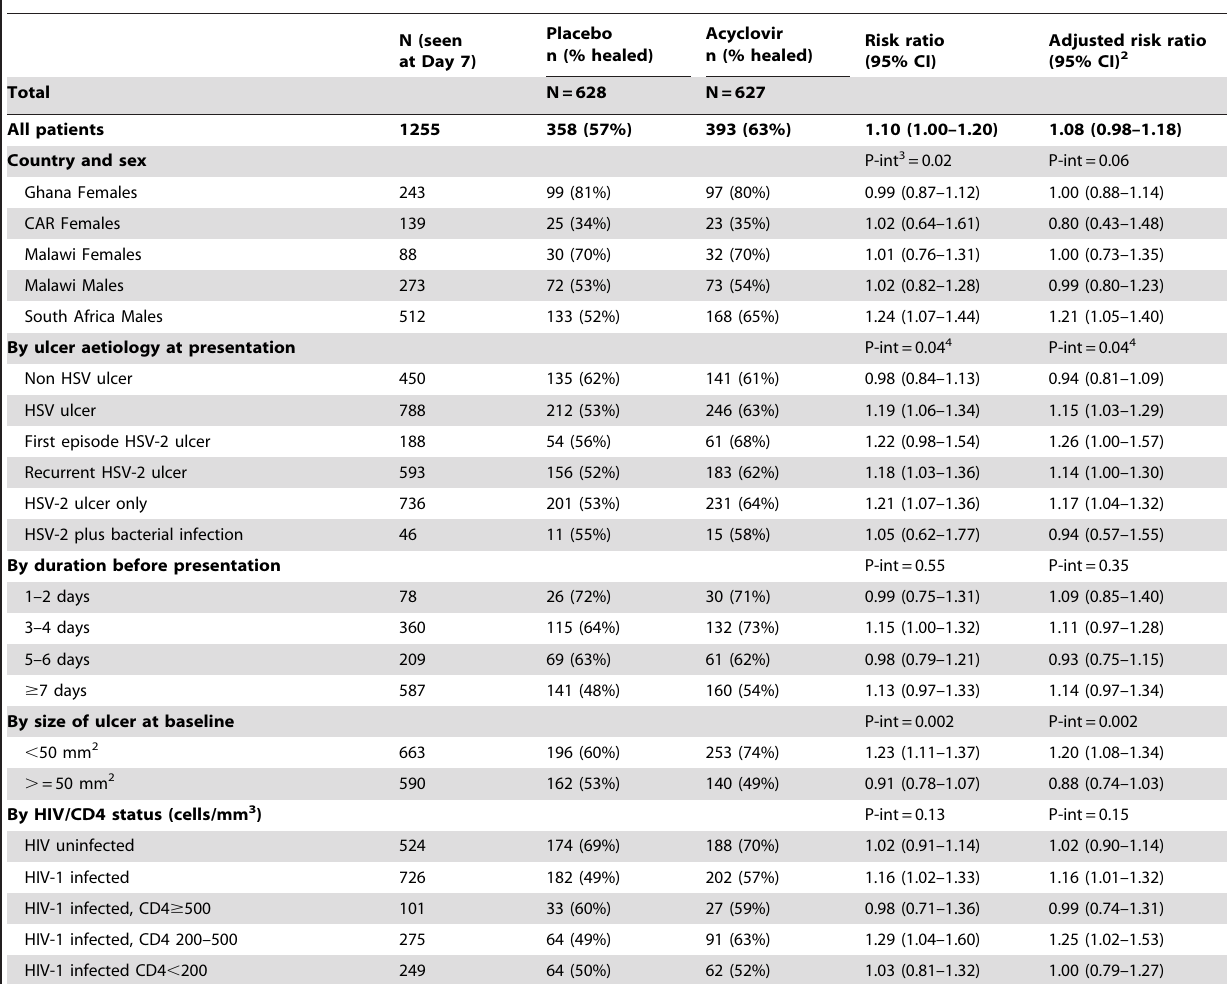
Table 4. Impact of acyclovir on ulcer healing 1 at Day 7 among 1255 trial participants.